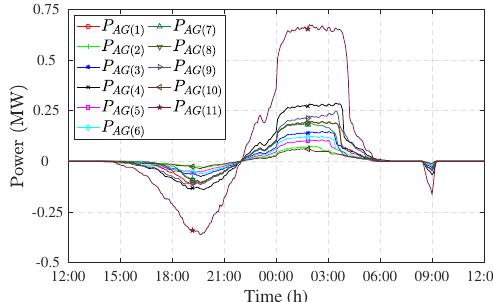
Figure 10. EV aggregators daily power profile with proposed scheme for 10% EV penetration level with 3 kW charger